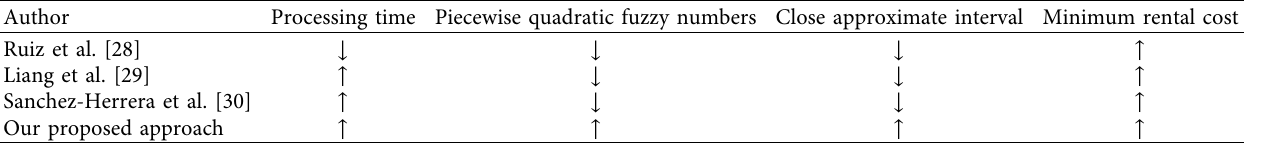
Table 11: Comparison of different researchers’